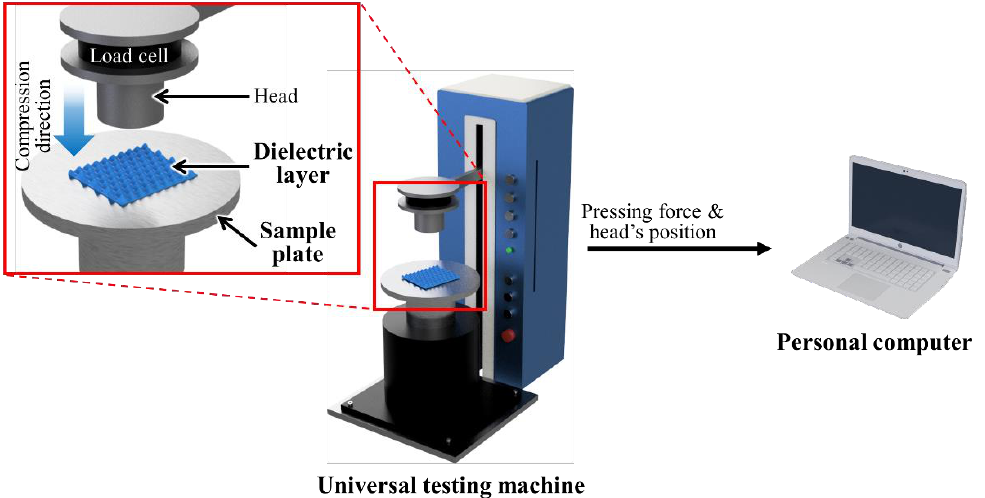
Figure 4. Experimental environment for investigating the mechanical properties of the dielectric layer samples.